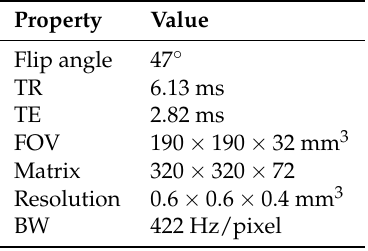
Table 1. 3DFT-CISS sequence parameters that allow high-resolution imaging of the whole vestibular system.